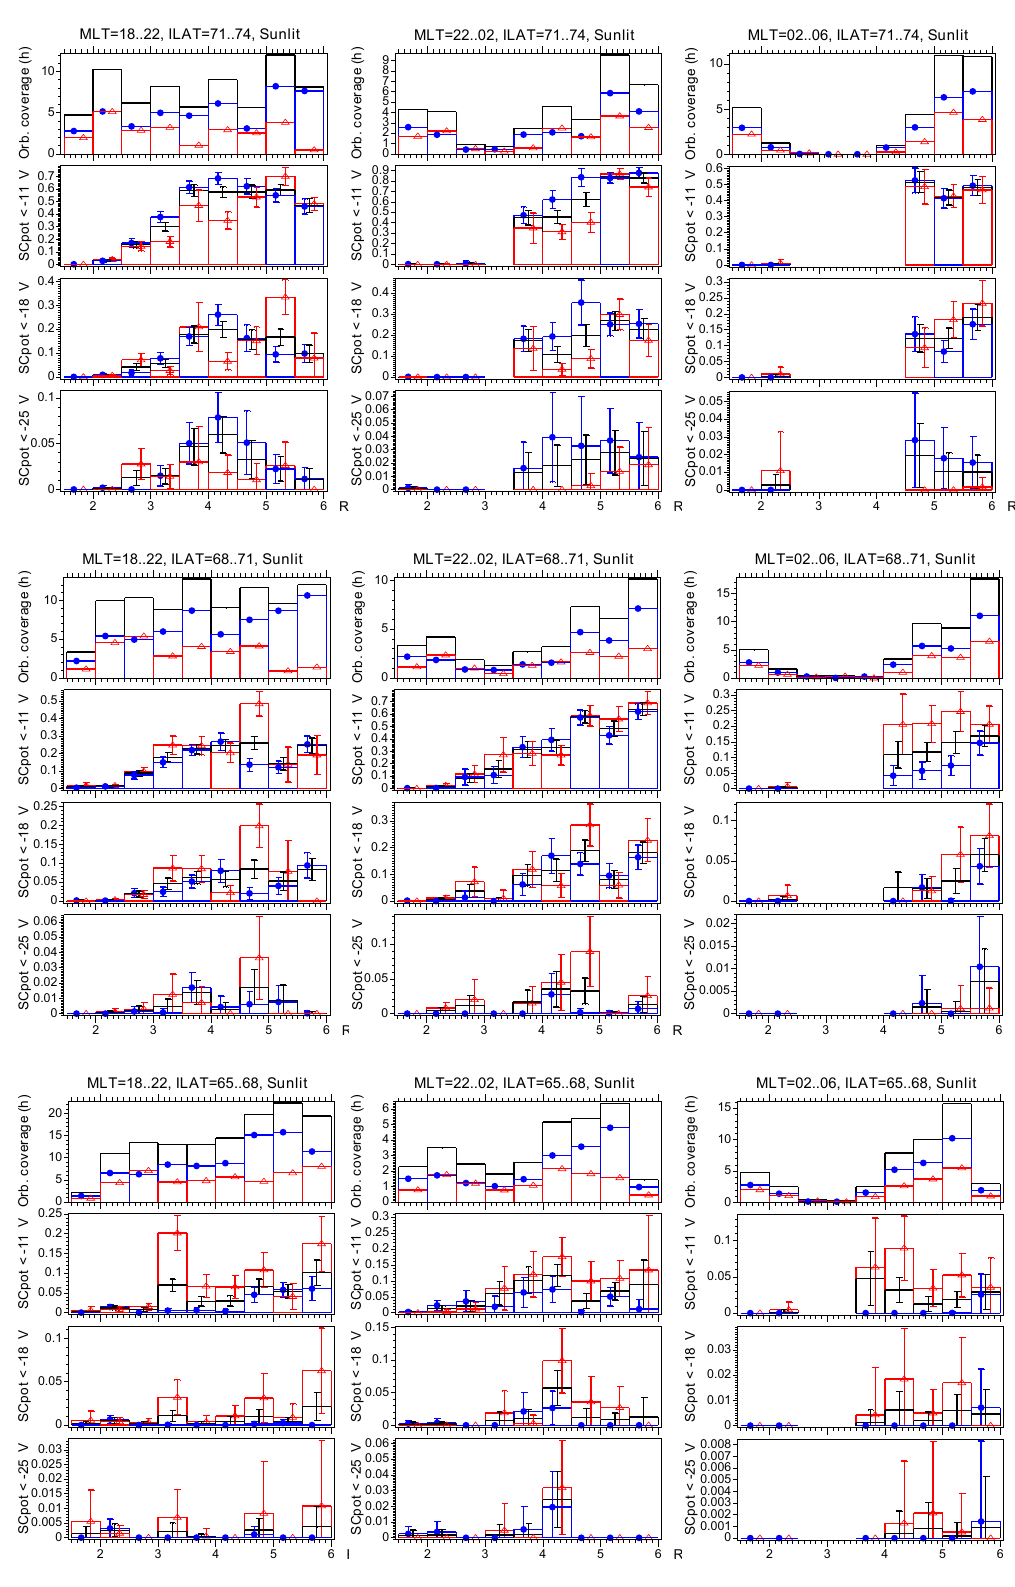
Fig. 6. Same as Fig. 5, but for conditions when the ionospheric footpoint is